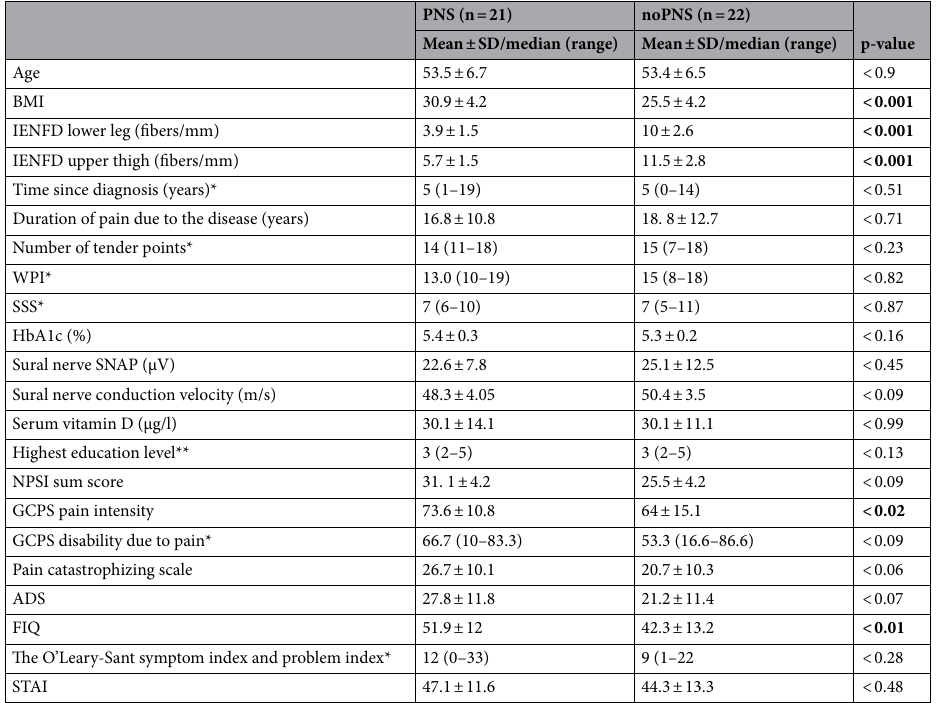
Table 2. Clinical and questionnaire data compared between subgroups. ADS Allgemeine depressionskala, BMI body mass index, FIQ Fibromyalgia Impact Questionnaire, GCPS Graded Chronic Pain Scale,